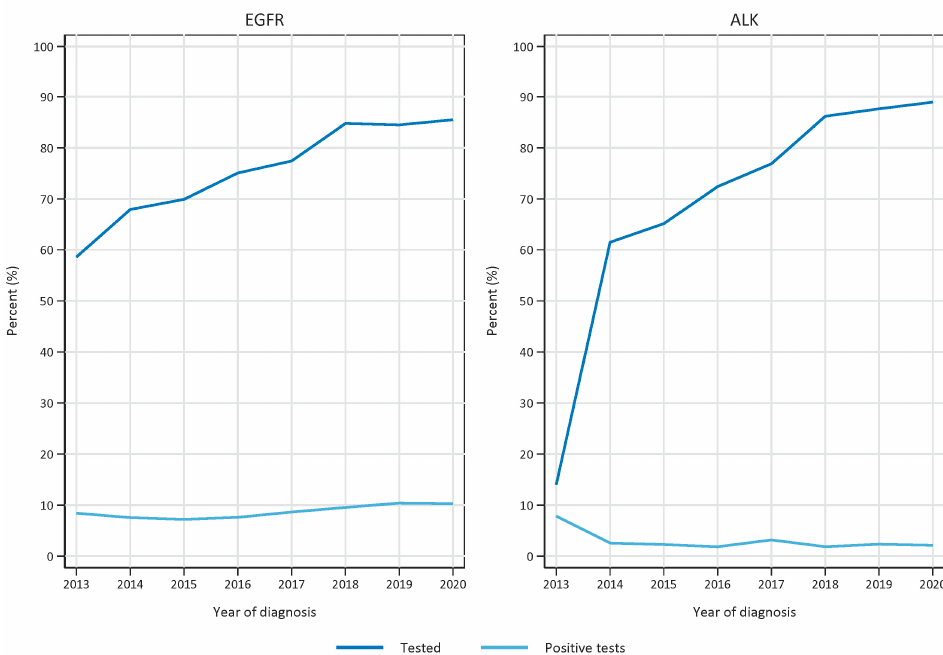
Figure 1. Test rate (number of tests versus number of diagnosed non-squamous non-small cell lung cancer patients) and fraction of positive tests per year in the period 2013–2020. Left panel represents EGFR tests and right panel represents ALK tests.